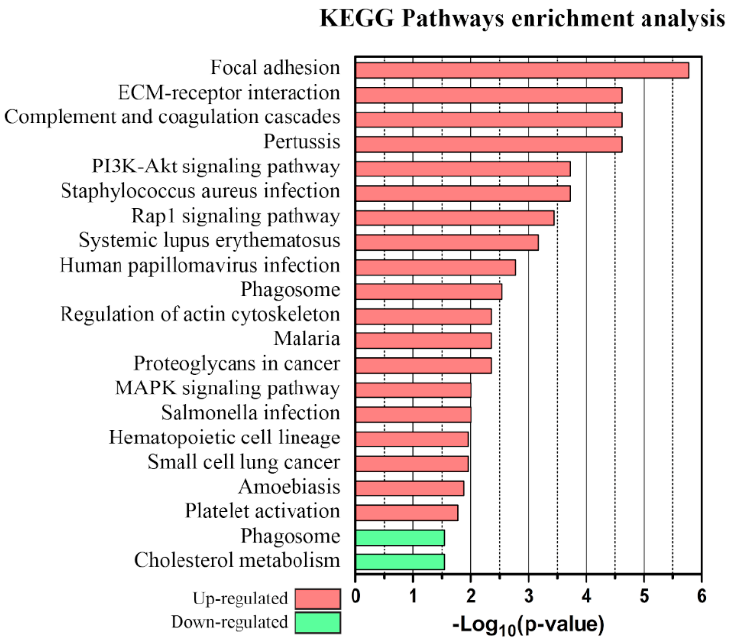
Figure 5. KEGG pathways GO enrichment analysis of proteins upregulated (red) or downregulated (green) in at least one time point.